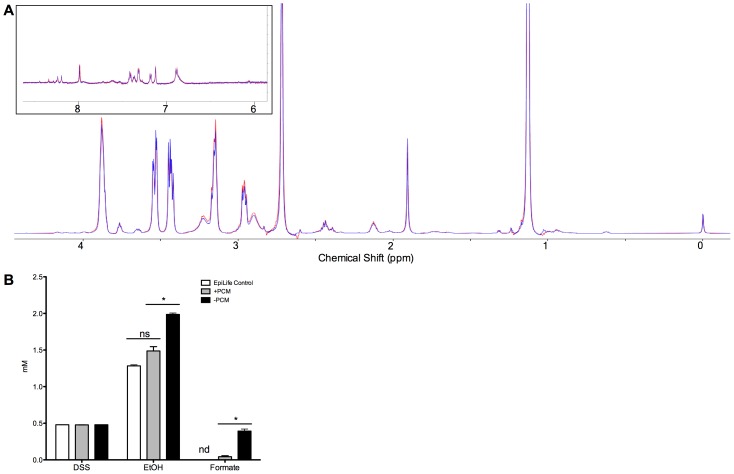
Analysis of +PCM and –PCM by NMR revealed minimal differences in metabolite composition.(A) Representative raw NMR spectra of +PCM (red) and –PCM (blue) did not show any major differences in metabolite compositions. (B) Analysis of NMR spectra by Chenomx revealed only two compounds, ethanol and formate, that were produced in higher quantities in –PCM relative to +PCM. DSS is the chemical shape indicator. Data represent means ± SEM, n = 3, *p<0.02. ns, not significant, nd, not detected.